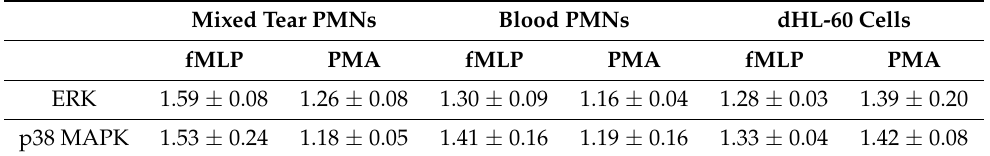
Figure 7. Comparison of the expression of membrane receptors on MACS-isolated or EasySep-isolated tear PMNs with mixed tear PMNs (non-isolated tear PMNs). M: MACS-column cell separation; E: EasySep cell separation. Once cells were collected from the ocular surface, tear PMNs were isolated either by MiniMACS column or the EasySep cell separation system. Samples from the non-isolated cell collection, concentrated by centrifugation, were used as controls. Cells were stained with fluorescently conjugated antibodies and analyzed by flow cytometry. Tear PMNs were identified by side scatter characteristics and CD45. The red line represents a ratio of 1, meaning no difference between the isolated tear PMNs and non-isolated mixed tear PMNs. Values are presented as means ± standard deviations. n = 5 from same 5 participants for each cell separation system. * Significantly different from the non-isolated mixed tear PMNs ( p ≤ 0.042, paired t test). Table 4. Changes in the expression of ERK and p38 MAPK on tear PMNs, blood PMNs and dHL-60 cells in response to fMLP and